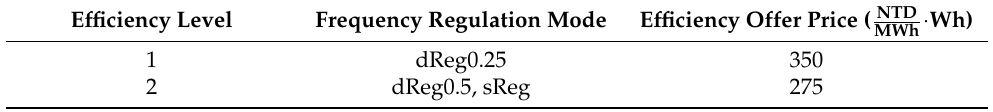
Table 1. Efficiency level and the price of each